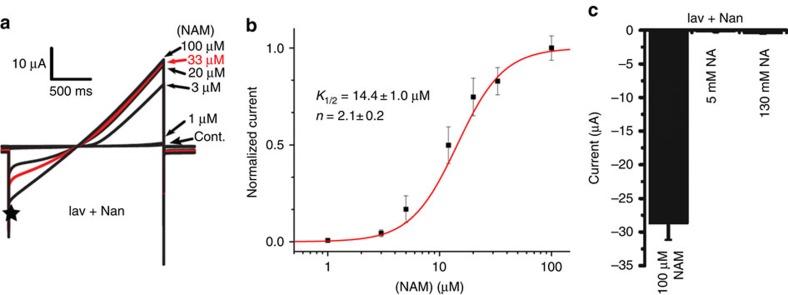
Drosophila Inactive (IAV) and Nanchung (NAN) channel is activated by NAM.(a,b) An example trace of the effect of NAM on the Nan–Iav channel. Large NAM-activated currents were observed in oocytes co-expressing Nan and Iav. Currents were recorded in response to 2 s voltage ramps from −100 to +100 mV from a −20 mV hold. Current size was measured at −100 mV (star), and the half maximal concentration (K1/2) for current activation by NAM was determined from the Hill plot shown in b. Points and bars in b represent mean±s.e.m. normalized current at a given concentration of NAM (n=5–13 oocytes per NAM concentration). The Hill coefficient (n) is estimated to be about 2.1. This is consistent with the estimated Hill coefficient for the OSM-9-OCR-4 channel (4d), suggesting that the number of NAM binding sites is conserved in invertebrate TRPV channels. K1/2 appears to be about 14 μM, which implies 4–5 fold greater affinity of NAM by the Nan–Iav channel compared with the OSM-9-OCR-4 channel (4d). The number of NAM binding sites for the Nan–Iav channel is estimated to be 2, which is consistent with the number of NAM binding sites for the OSM-9-OCR-4 channel. (c) Current is not induced in Nan–Iav channel by 5 mM NA (−0.188±0.020 μA, n=3); There is a slight increase in the conduction of the Nan–Iav channel upon exposure to 130 mM NA (−0.422±0.040 μA, n=4). Though this is a statistically significant increase (P<0.01, two-tailed t-test), this high level of NA (130 mM) elicited over 50-fold less current compared with 1,000-fold less NAM.